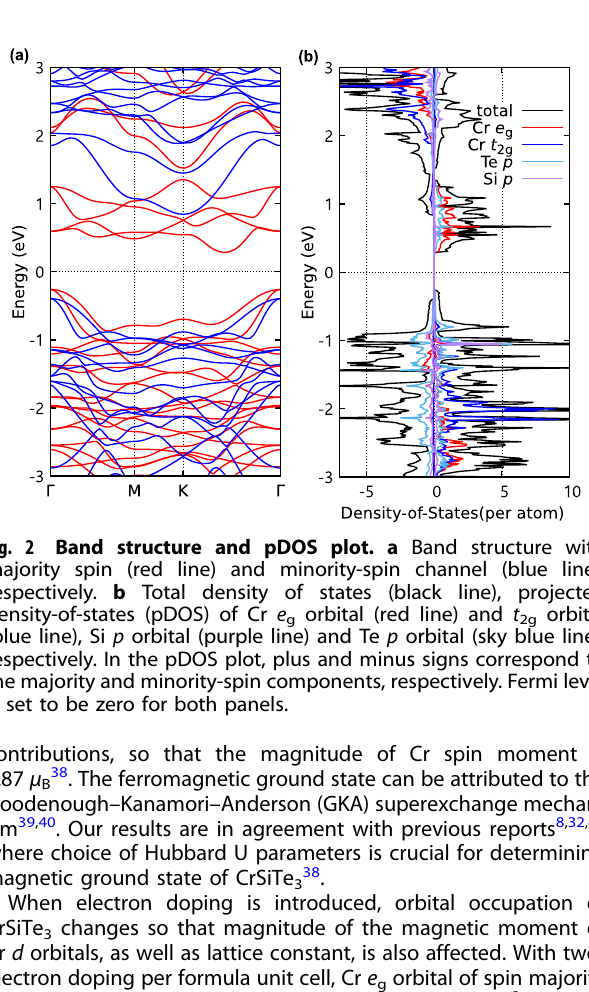
Fig. 1 Crystal structure of monolayer CrSiTe 3 (top view). The unit cell features the Cr 2 Si 2 Te 6 formula unit. Edge sharing CrTe 6 octahedron consists of Cr atom (gray sphere) and surrounding six Te atoms (yellow sphere). Dimerized two Si atoms (blue sphere) are sitting at center of Cr honeycomb lattice. a , b , c is unit vector of hexagonal unit cell, where x , y , z indicates local axis.